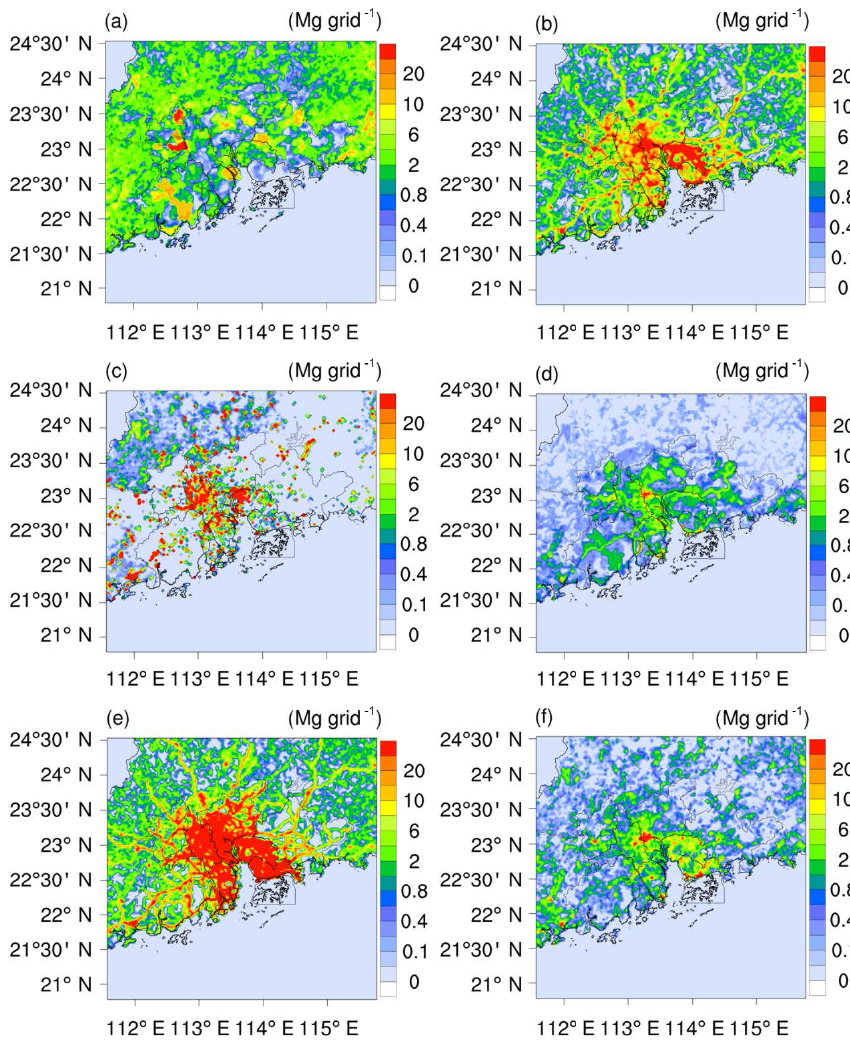
Figure 3. Spatial distribution of S–IVOC emissions from different source categories for the year 2010: (a) biomass burning, (b) dust, (c) industry, (d) off-road mobile sources, (e) on-road mobile sources, (f) residential